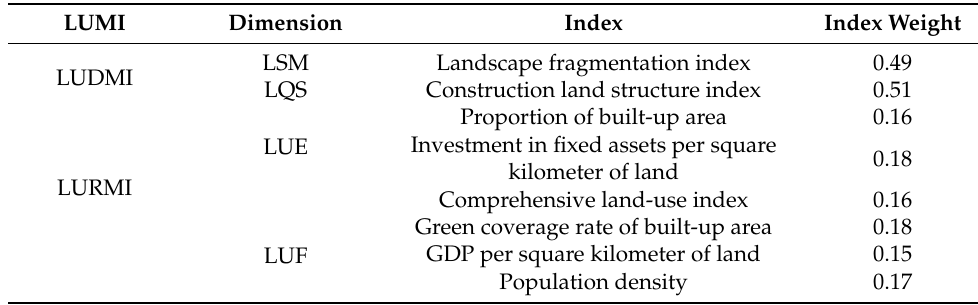
Table 2. Land-use measurement index